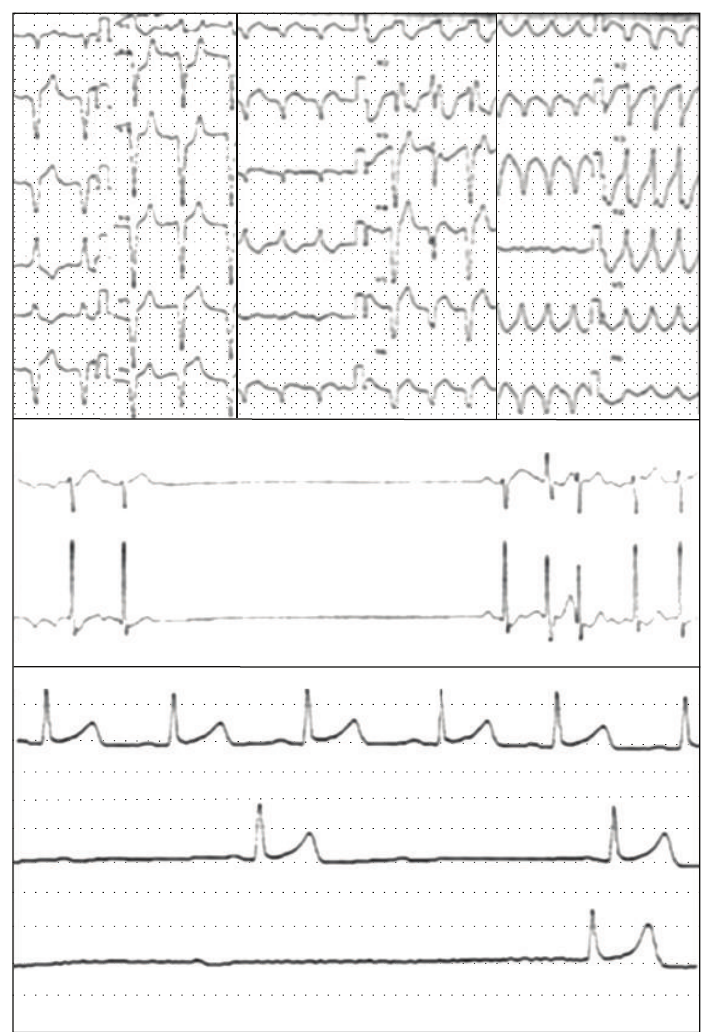
Figure 1: Electrocardiogram in myasthenia gravis patients with anti-Kv1.4 antibodies. (a) Ventricular tachycardia, (b) sick sinus syndrome, and (c) complete atrial ventricular